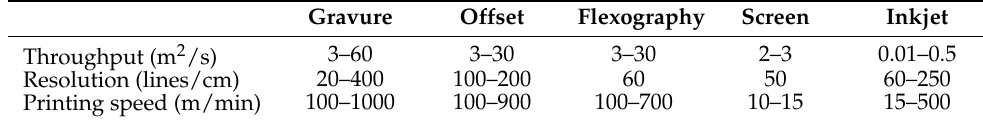
Table 2. Key properties and parameters of different printing methods